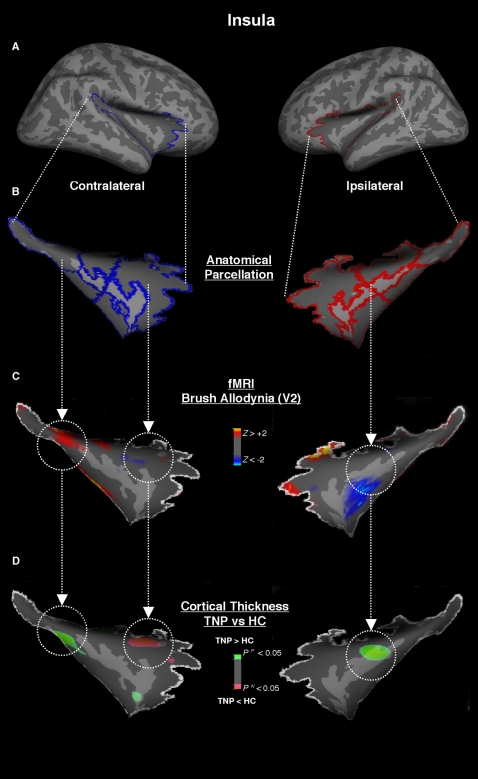
Insula.
Panel A and B - The insula was subdivided in seven-parcellated sections along the lateral fissure posterior, insular superior and inferior sulci and the insular gyrus. Panel C - We found contralateral allodynic activation in the posterior insula (lateral fissura posterior) and deactivation in the medial and anterior insula in TNP patients. Panel D – Functional (de)activations were colocalized with cortical thickness changes when comparing TNP and HC groups, with thickening in the posterior and medial insula and thinning in the anterior insula.